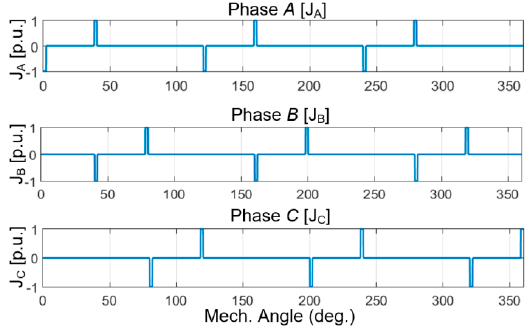
Figure 3. Current sheet spatial distribution in space of each phase in per unit for AFPM with six poles and nine stator slots.